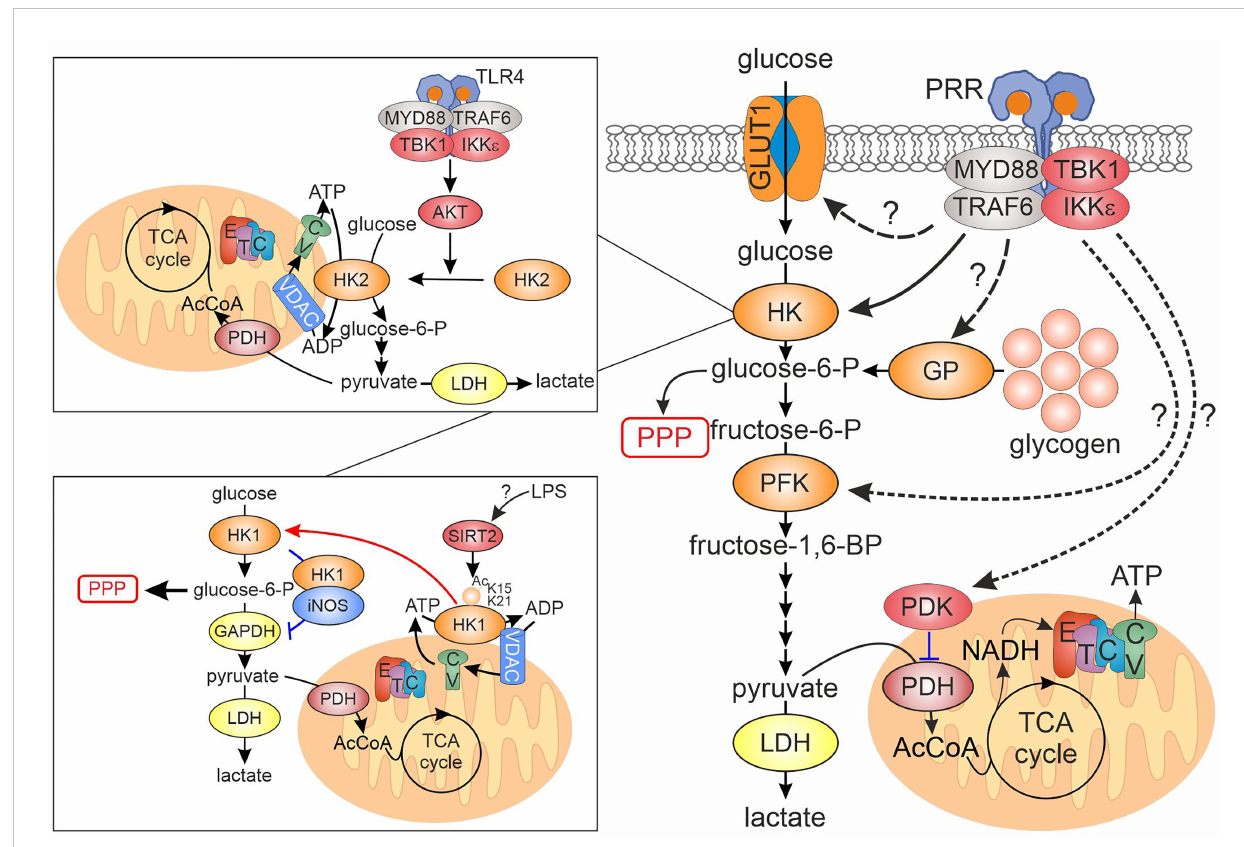
FIGURE 1 Regulation of rapid glycolytic activation upon PRR ligation in innate immune cells. PRR ligand recognition initiates the assembly of myddosome signaling complex, which, among others, includes the kinases TBK1 and IKK e . Activated myddosome is linked to the fi rst step of the glycolytic cascade, hexokinase (HK), either through relocation of HK2 from the cytosol to mitochondria, or via movement of HK1 from mitochondria to cytosol (insets, details in the text). Other points of the glycolytic cascade affected by the activated myddosome include glucose entry via GLUT1 glucose transporter and glycogen breakdown via glycogen phosphorylase, but exact mechanistic details remain elusive. Whether regulation of the cascade via phosphofructokinase or pyruvate dehydrogenase kinase, reported for other cellular systems, is relevant for activated myeloid cells remains unknown. CV, complex V; ETC, electron transport chain; GAPDH, glyceraldehyde-3-phosphate dehydrogenase; GP, glycogen phosphorylase; HK, hexokinase; IKK, inhibitor of nuclear factor kappa B kinase; LDH, lactate dehydrogenase; MYD88, myeloid differentiation primary response gene 88; PDH, pyruvate dehydrogenase; PDK, pyruvate dehydrogenase kinase; PFK, phosphofructokinase; PPP, pentose phosphate pathway; PRR, pattern recognition receptor; TBK1, TANK-binding kinase 1; TCA, tricarboxylic acid; TLR, toll-like receptor; TRAF6, tumor necrosis factor receptor-associated factor 6; VDAC, voltage-dependent anion